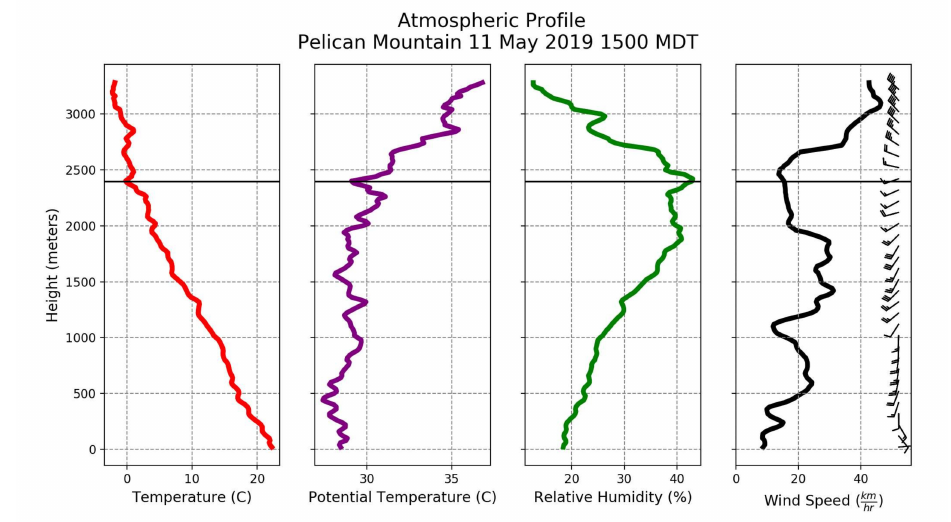
Figure 4. Radiosonde profile launched on-site three hours prior to